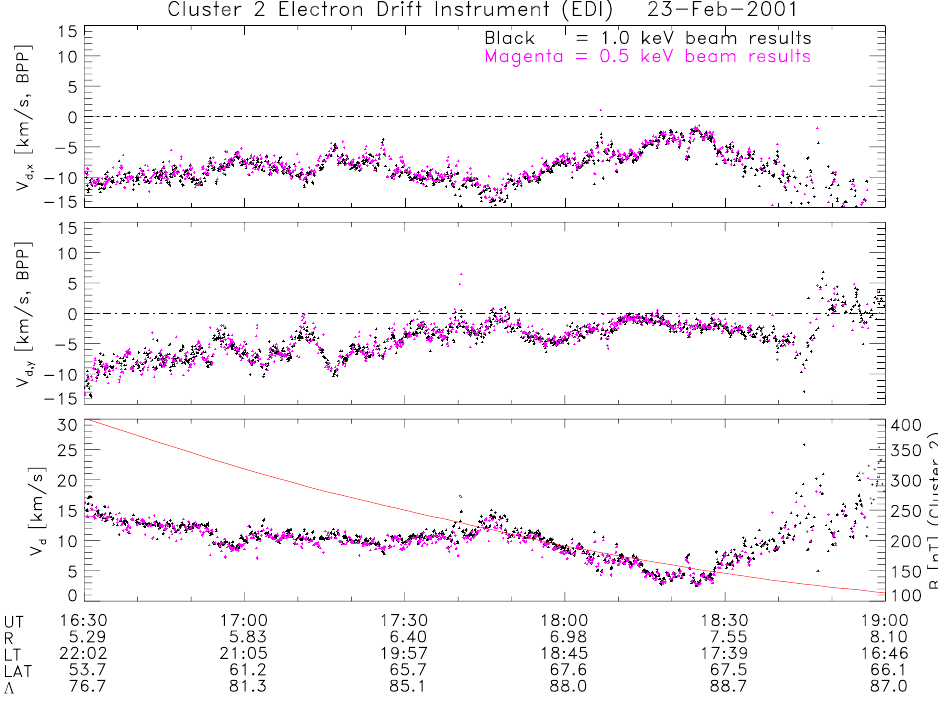
Fig. 11. Comparison of the drift velocities measured at 0.5 and 1.0keV for the pass on 23 February, 16:30–19:00 UT. The plot shows the two components of the drift in the B ⊥ -plane, plus the magnitude. The magnitude of B is shown superimposed in the bottom